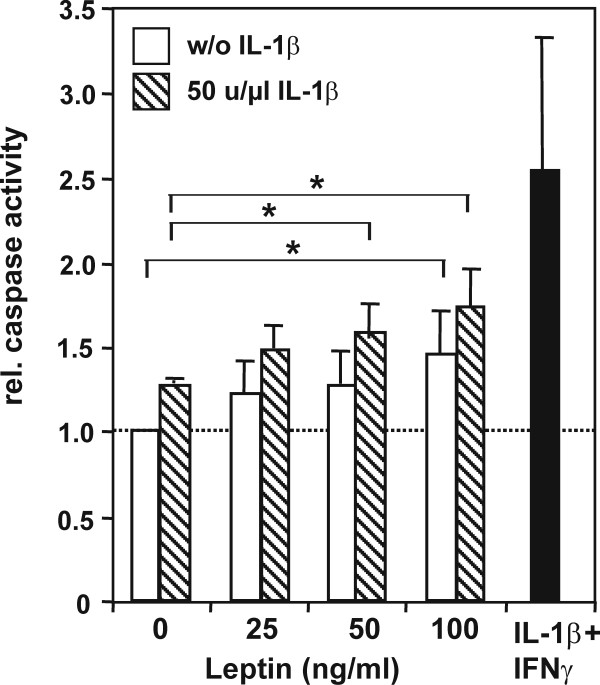
Leptin induces caspase activity in RINm5F cells. LEPRb-expressing RINm5F cells were exposed to the indicated concentrations of leptin for 48 h, alone (open bars) or in combination with 50 u/ml IL-1β (hatched). Alternatively, cells were treated with a mix of 50 u/ml IL-1β and 50 ng/ml IFNγ. Caspase activity was determined in total cell lysates as the sequence-specific cleavage of a proluminescent DEVD-aminoluciferin substrate. Data are expressed as fold stimulation by the cytokine treatment relative to unstimulated cells. Bars reflect means +/- SD of 4 independent experiments. * P < 0.05, treated vs. untreated. The effect of 50 u/ml IL-1β and 50 ng/ml IFNγ was not significantly greater than that of 50 u/ml IL-1β plus 100 ng/ml leptin (P = 0.058)